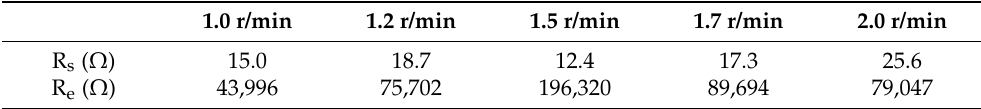
Figure 18. Electrochemical test results of the coating at different feeding motor speeds: ( a ) Nyquist diagram, ( b ) equivalent circuit model diagram. Table 6. EIS fitting fruit of Al – Zn composite coating soaked in 3.5 wt % NaCl solution at the initial stage at different feeding motor speeds.